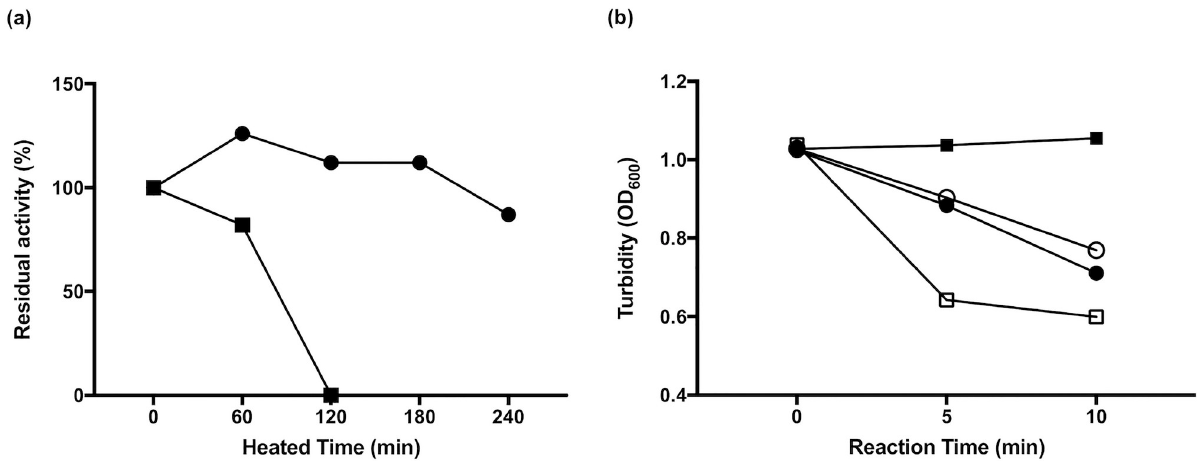
Fig 11. Heat stability of lysozyme and LYZOX. (a) The effects of heat were tested with lysozyme-chitosan oligosaccharide (LYZOX) and lysozyme exposed to 80˚C for various times. The lytic activity of heated agents against Micrococcus luteus for 10 min were measured at OD 600 . The values are the per cent of residual activity. Symbols: filled circles, LYZOX, filled squares, lysozyme. (b) Comparison of lytic activity of LYZOX and lysozyme for 120 min at 80˚C. Lytic activity against Micrococcus luteus was measured at OD 600 . Symbols: open circles, non-heated LYZOX; filled circles, heated LYZOX; open squares, non-heated lysozyme; filled squares, heated